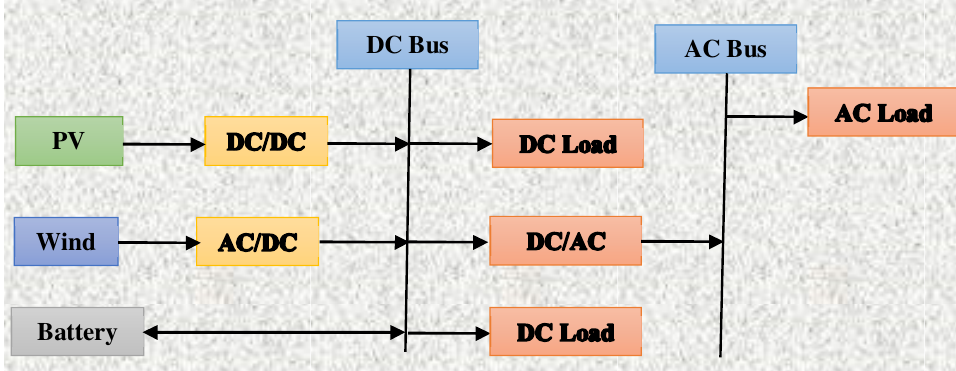
Fig. 1: Block diagram of a microgrid renewable system comprised of solar PV-wind, and battery hybrid system